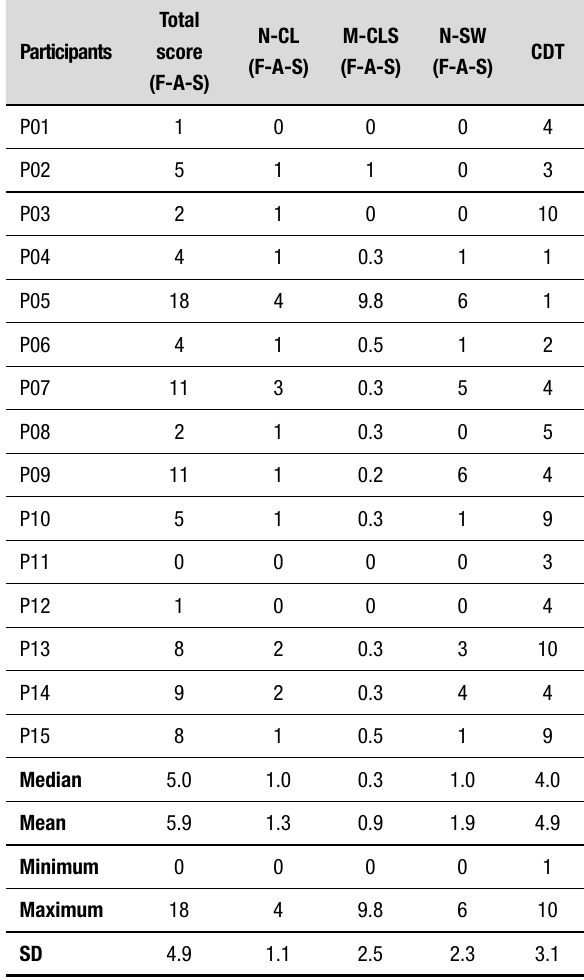
Table 2. Performance in the F-A-S test and clock drawing test. Participants